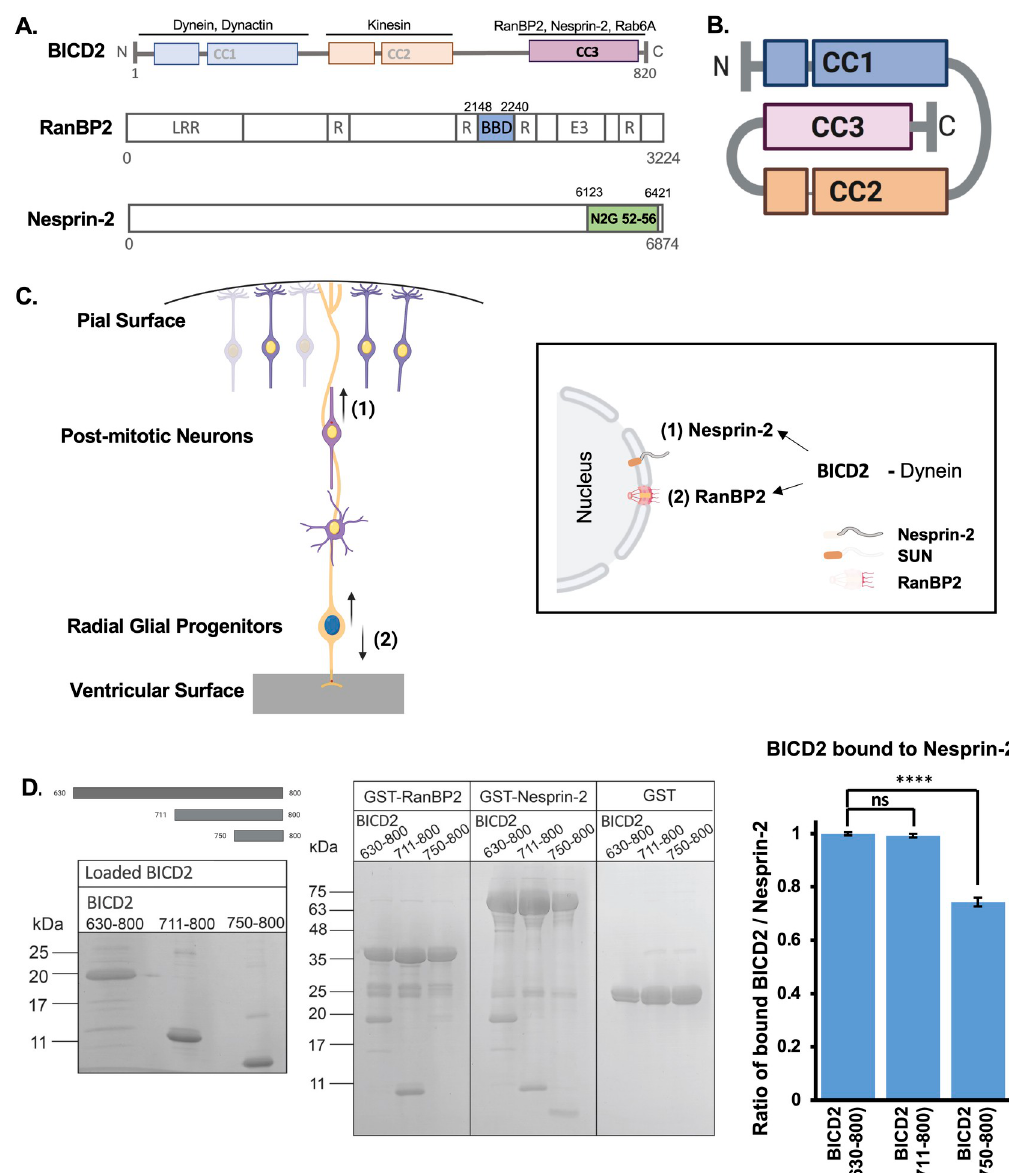
Fig 1. Structural organization and interactions of BICD2, RanBP2, and Nesprin-2. (A) Schematic representation of BicD2 (top), RanBP2 (middle), and Nesprin-2 (bottom). BicD2 (top): The colored boxes represent the three coiled-coil domains (CC1, CC2, and CC3) of the BICD2 protein. Interactors for each domain are noted on top. RanBP2 (Middle): A drawing of RanBP2 (modified from [14]), showing leucine-rich region (LRR), an E3 Sumo ligase domain (E3), and four Ran-binding domains (R), two of which flanking the BicD2 binding domain (BBD). “BBD” (highlighted in blue) of RanBP2 is used in the biochemical assays of this study. Nesprin-2 (bottom): A drawing of Nesprin-2 [3, 21] with “N2G 52–56” highlighted in green. The BicD2 binding “N2G 52–56” fragment [3] is used in the biochemical assays of this study. (B) Schematic depiction of BICD2 in an autoinhibited state. (C) Drawing of the cerebral cortex during development (Left). Both the apical nuclear migration of Radial Glial Progenitors and the basal migration of post-mitotic neurons are mediated by dynein, which is recruited to the nuclear envelope via two distinct pathways: (2) RanBP2- or (1) Nesprin-2-BICD2 interactions (Right). (D) Left panel: BICD2 fragments used in the GST pull-down (Top left). A Coomassie-stained SDS-PAGE of the purified BICD2 fragments used in the GST pull-down assay is shown below. Middle panel: An SDS-PAGE of the elution fractions of the GST- pulldown assay is shown. The GST-tagged RanBP2 fragment (BICD2 binding domain, aa 2148–2240) pulls down the BICD2 fragments aa 630–800 and aa 711–800, but not the fragment aa 750–800. The GST-tagged Nesprin-2 fragment (BICD2/Dynein binding domain, for the sequence see S1A Fig) pulls down each of the three BICD2 fragments. A pull-down assay with GST is shown as a negative control. The molar masses of standards are indicated on the left of each SDS-PAGE. Right panel: